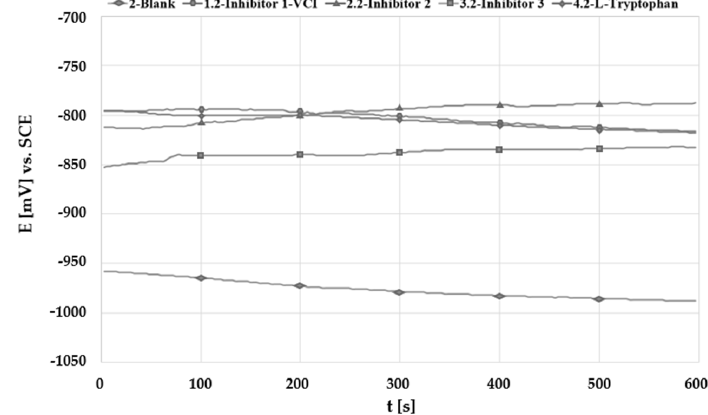
Figure 2. Corrosion potential diagram with and without the addition of inhibitors in distilled water.